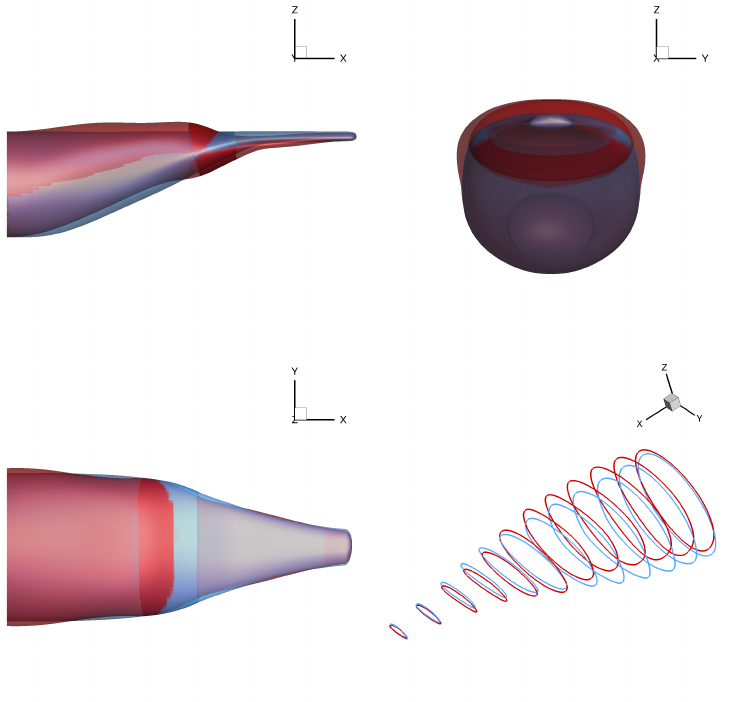
Figure 15. Surface comparison of military transport aircraft optimization (blue: initial; red: